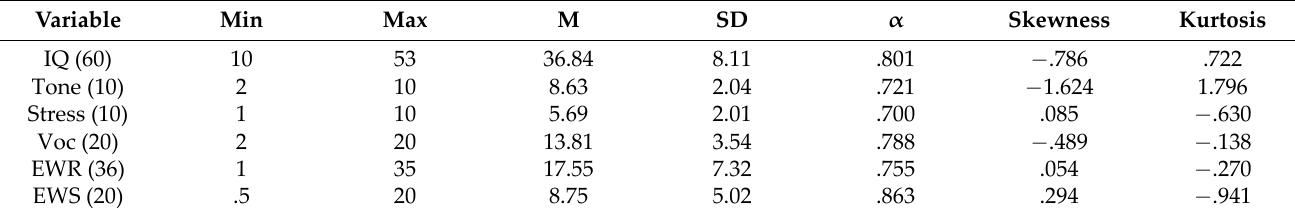
Table 1. Descriptive Statistics of all